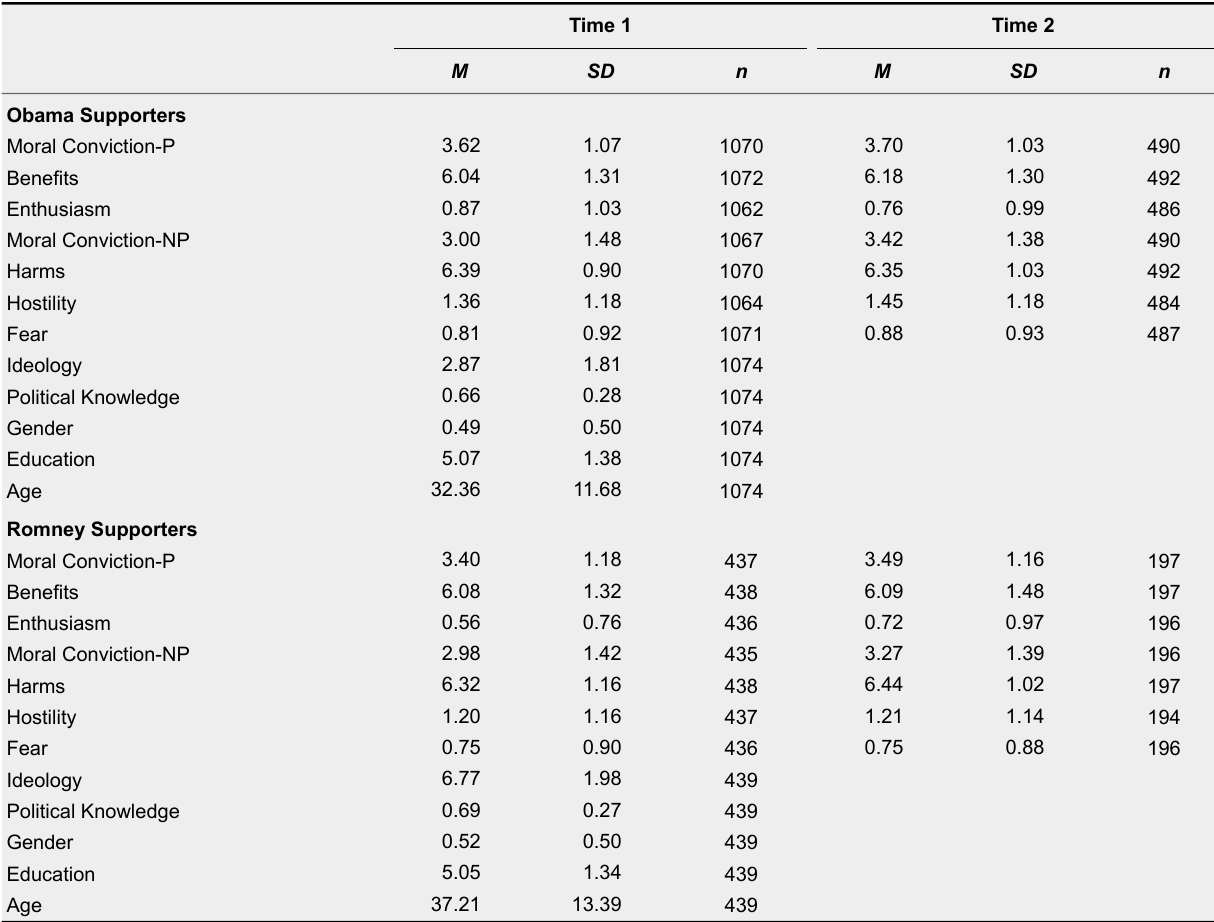
Means, Standard Deviations, and Available n for Each Measure From Time 1 and Time